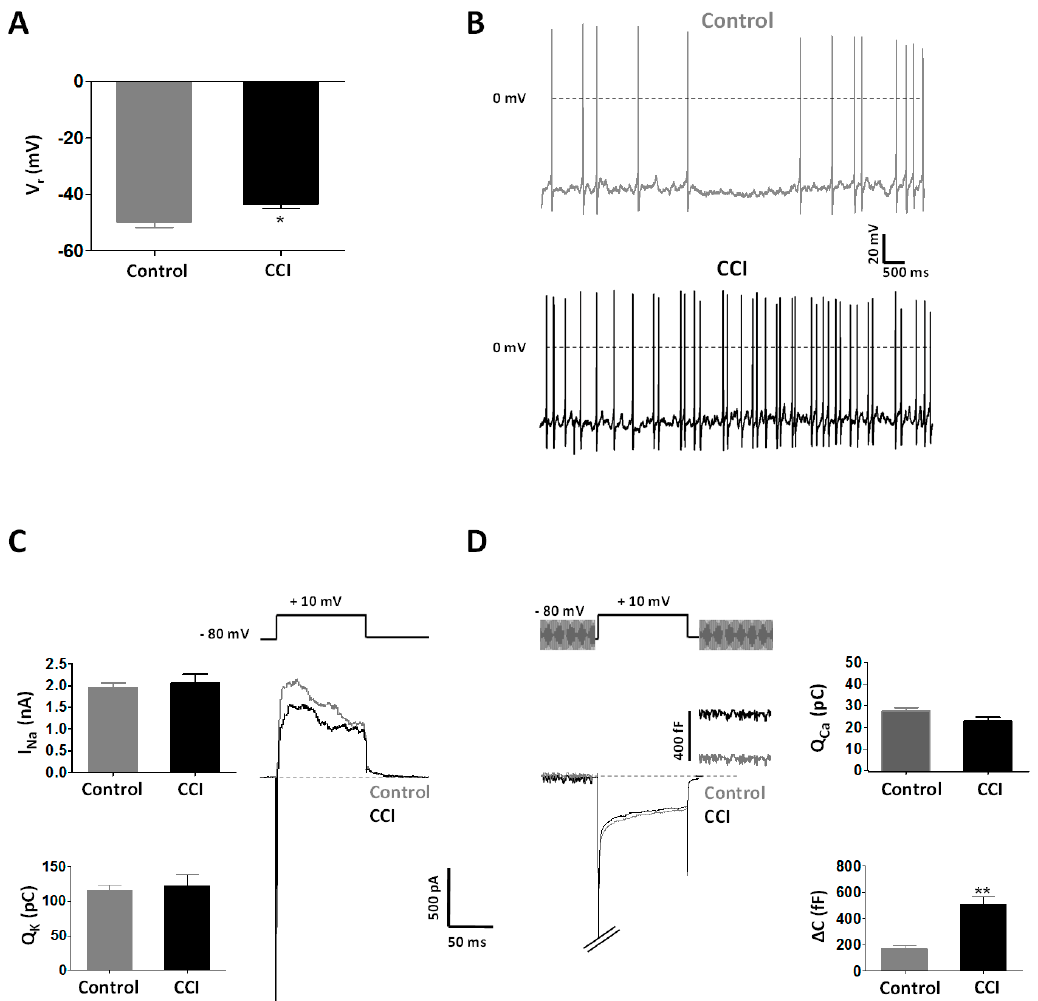
Figure 4. Chromaffin cells from CCI animals exhibit increased electrical excitability and exocytosis. ( A ) Resting membrane potential (V r ) in chromaffin cells of the adrenal gland from Control ( n = 40 cells, 17 rats) and CCI ( n = 29 cells, 9 rats) animals. ( B ) Spontaneous action potentials recorded in chromaffin cells from Control and CCI animals. Recordings are representative of those obtained in 11 cells from 5 Control animals and 5 cells from 2 CCI animals, respectively. V comm = − 60 mV. ( C ) Voltage-activated Na + and K + currents in chromaffin cells from Control and CCI animals. The voltage protocol appears on top of the recordings. V h = − 80 mV. Inset . Peak amplitudes of Na + currents (upper graph) and charge (Q) of K + currents (lower graph) evoked by voltage depolarization in chromaffin cells from Control ( n = 40 cells, 9 rats) and CCI ( n = 29 cells, 9 rats) animals. ( D ) Voltage-activated Ca 2+ currents and membrane capacitance changes in chromaffin cells from Control and CCI animals. The voltage protocol appears on top of the recordings. Note that membrane capacitance measurements were interrupted during membrane depolarization activating the Ca 2+ conductance. V h = − 80 mV. Inset . Charge (Q) of Ca 2+ current (upper graph) and increases in membrane capacitance ( ∆ C; lower graph) evoked by voltage depolarization in chromaffin cells from Control ( n = 25 cells, 9 rats) and CCI ( n = 25 cells, 10 rats) animals. Statistical significances were assessed by a Student t test for unpaired data. *, p < 0.05; **, p < 0.01. Scale bars apply to panels ( C , D